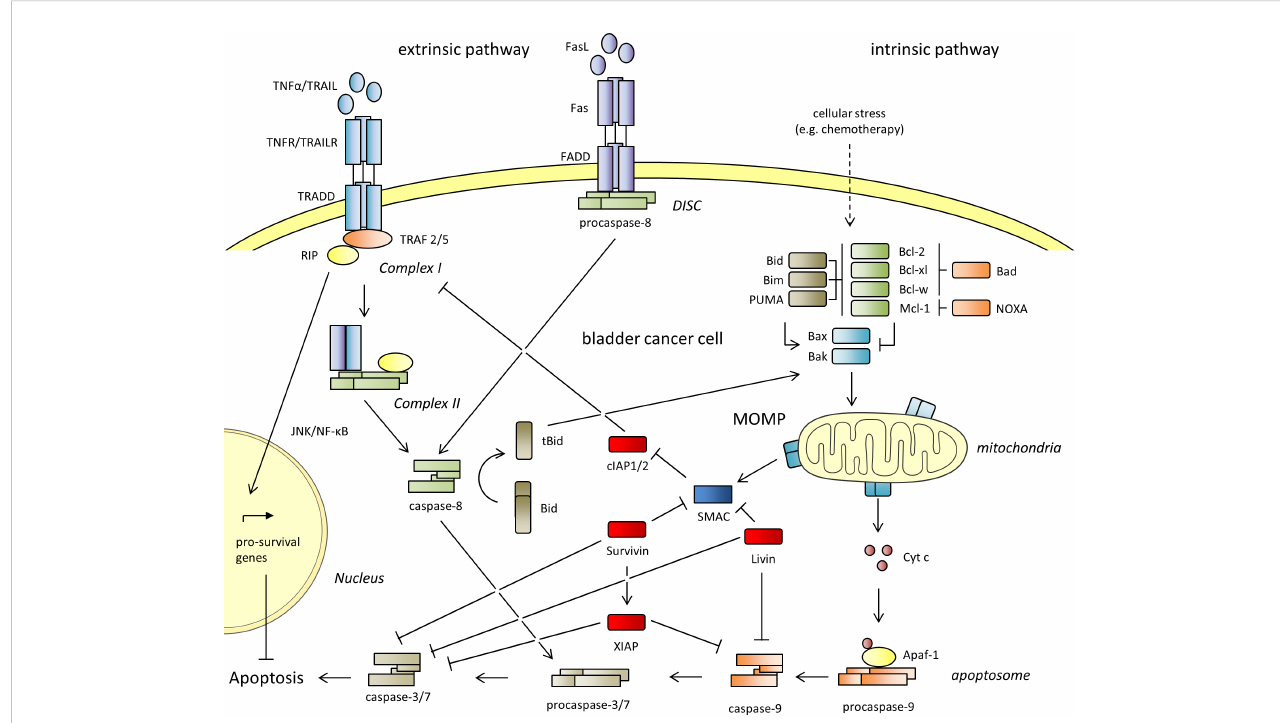
FIGURE 1 The extrinsic and the intrinsic apoptotic pathways. The Inhibitor of Apoptosis Proteins (IAPs) cIAP1 and 2, XIAP, Survivin and Livin are shown in red. They inhibit both pathways and lead to resistance against apoptosis. Apaf-1, apoptotic protease-activating factor 1; BAD, Bcl-2 antagonist of cell death; Bak, Bcl-2 antagonist/killer; Bax, Bcl-2 associated X protein; Bcl-2, B-cell lymphoma 2; Bcl-w, Bcl-2 like 2; Bcl-xl, B-cell lymphoma extra-large; BID, BH3 interacting domain death agonist; tBid, truncated Bid; BIM, Bcl-2 interacting mediator of cell death; Cyt c, cytochrome C; DISC, death-inducing signaling complex; FADD, Fas-associated protein with death domain; JNK, c-Jun N-terminal kinase; Mcl-1, myeloid cell leukemia sequence; MOMP, mitochondrial outer membrane permeabilization; NF- k B, nuclear factor kappa-light-chain-enhancer of activated B-cells; NOXA, phorbol-12-myristate-13-acetate- induced protein 1; PUMA, p53 upregulated modulator of apoptosis; RIP, receptor interacting protein; Smac, second mitochondria derived activator of caspases; TNF- a , tumor necrosis factor alpha; TRAIL, Tumor Necrosis Factor Related Apoptosis Inducing Ligand; TRADD, tumor necrosis factor receptor type 1-associated death domain protein; TRAF, TNF receptor associated